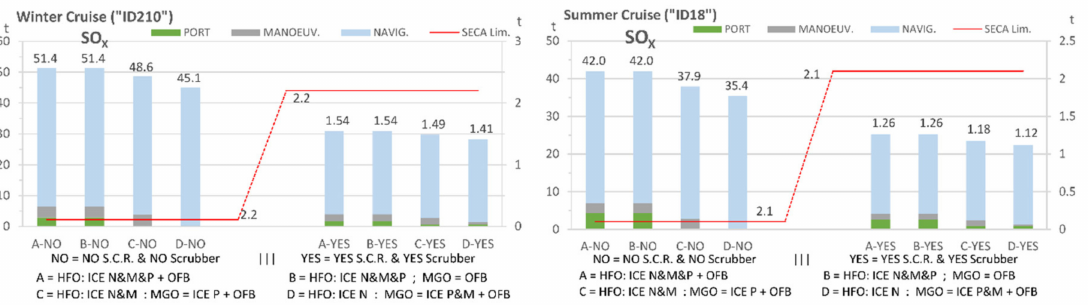
Figure 17. SOx emissions values, calculated for the winter / summer cruise, with di ff erent strategies for the usage of fuel and abatement devices.